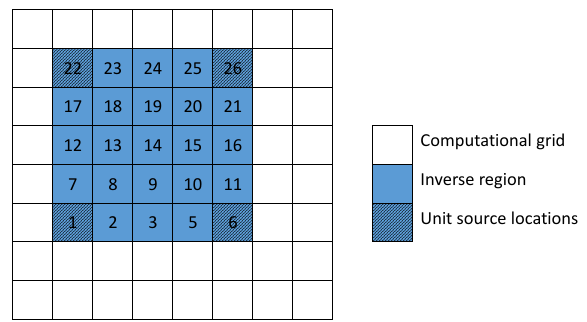
Figure 1. Example of a unique identification of the forward model computational grid used for the second design